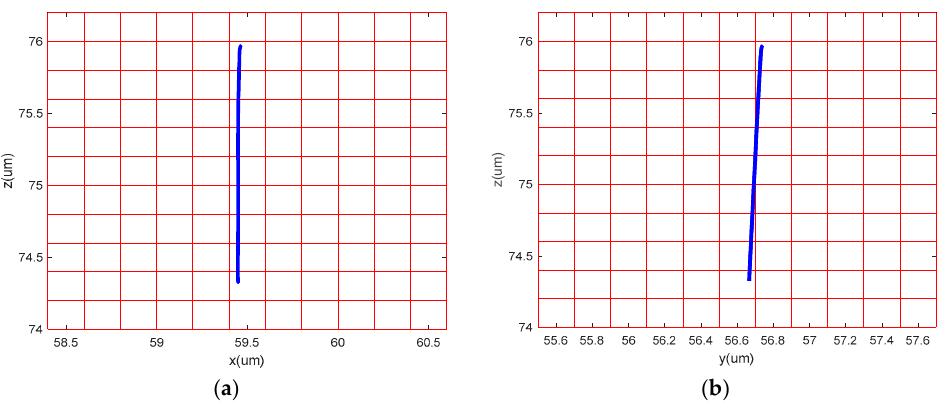
Figure 33. Linear motion performance test in z direction. ( a ) Projection on the xoz plane; ( b ) projection on the yoz plane.